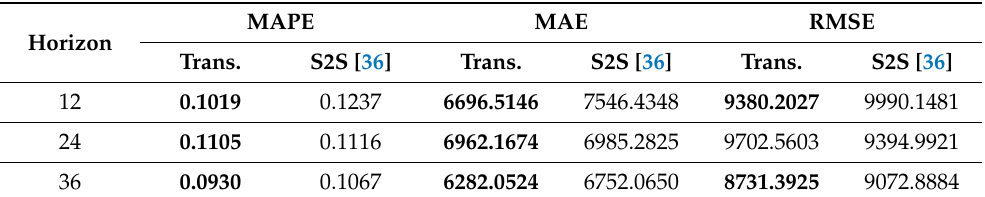
Table 3. Average performance metric per input window. The bold numbers indicate where trans- formers outperform S2S.